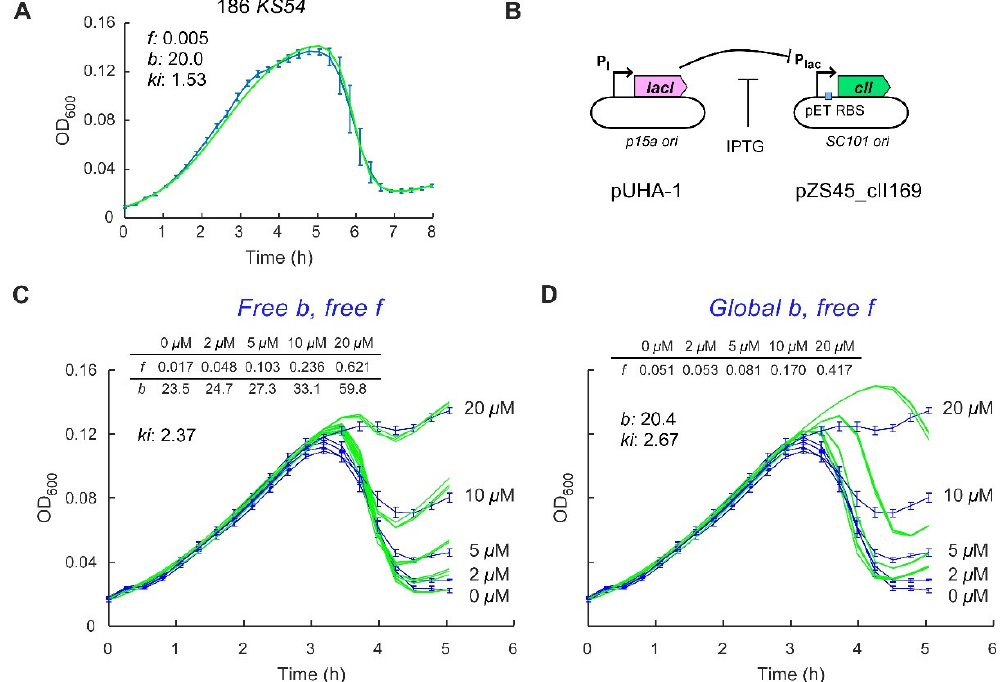
Figure 3. The role of CII in controlling the FOL in phage 186. ( A ) Infection time course (blue) and fittings (green) following 186 KS54 phage infection. ( B ) A two-plasmid system for controlled CII expression. The CII was expressed from low copy number pZS45_cII169 and was controlled by IPTG. The Lac repressor was expressed from a medium copy number plasmid (pUHA-1), under the control of its native promoter. ( C , D ) Infection time courses and fittings following 186 cII − phage infection at five different IPTG concentrations. The fitting was performed with either free b for each IPTG concentration ( C ) or a global b ( D ). All infections were performed at MOA of 1.5 × 10 − 4 . Error bars represent standard deviation, n = 6. For data fitting, three rounds of 50,000 iterations of fitting were performed, and the best fit from each round was plotted.